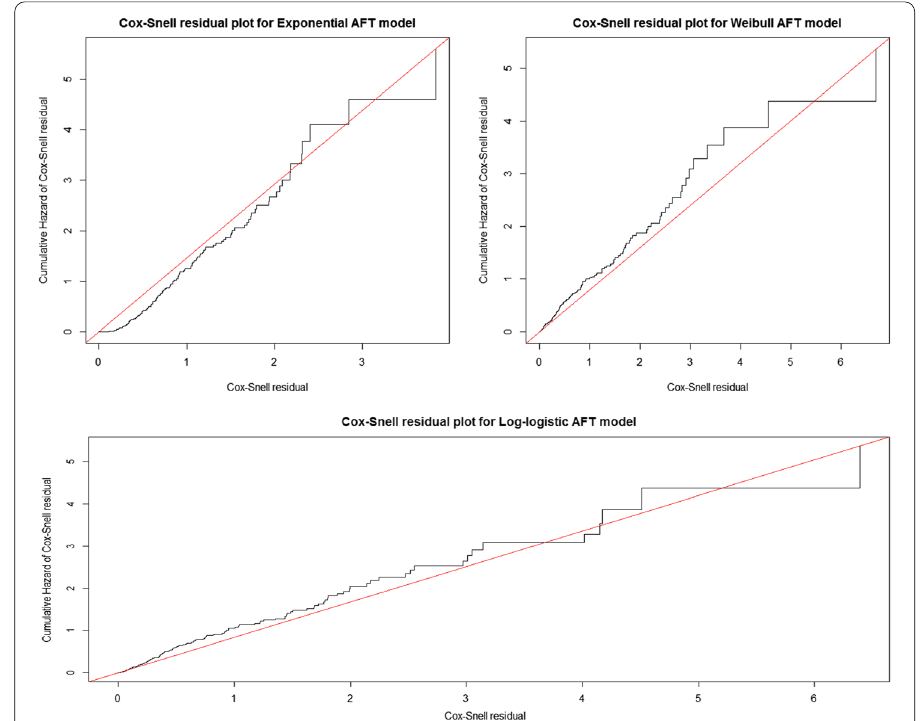
Fig. 3 Bayesian Cox-Snell residual plots for baseline distribution and Cox-PH that were used to fit the Heart failure data